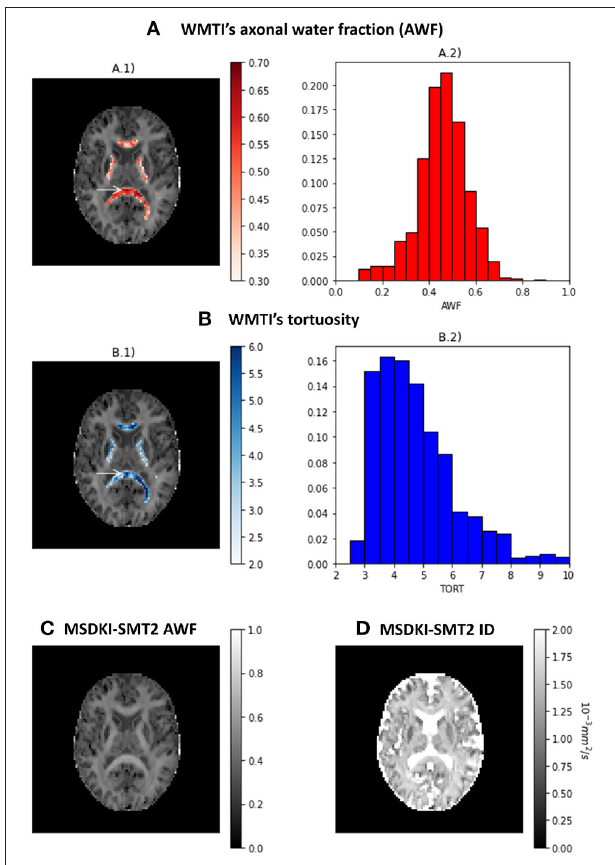
FIGURE 7 | Metrics from the kurtosis-based microstructural models: (A) Axonal water fraction (AWF) estimates from the white matter tract integrity model—(A.1) shows the AWF estimates of well-aligned fiber regions overlaid on a top of the mean signal kurtosis image, while (A.2) shows the histograms of AWF estimates for well-aligned fiber regions. (B) Tortuosity (TORT) estimates from the white matter tract integrity model—(B.1) shows the TORT estimates of well-aligned fiber regions overlaid on a top of the mean signal kurtosis image, while (B.2) shows the histograms of TORT estimates for well-aligned fiber regions. (C) Axonal water fraction (AWF) estimates from the spherical mean technique converted from the MSDKI model. (D) Intrinsic diffusivity (ID) estimates from the two-compartmental spherical mean technique converted from the MSDKI